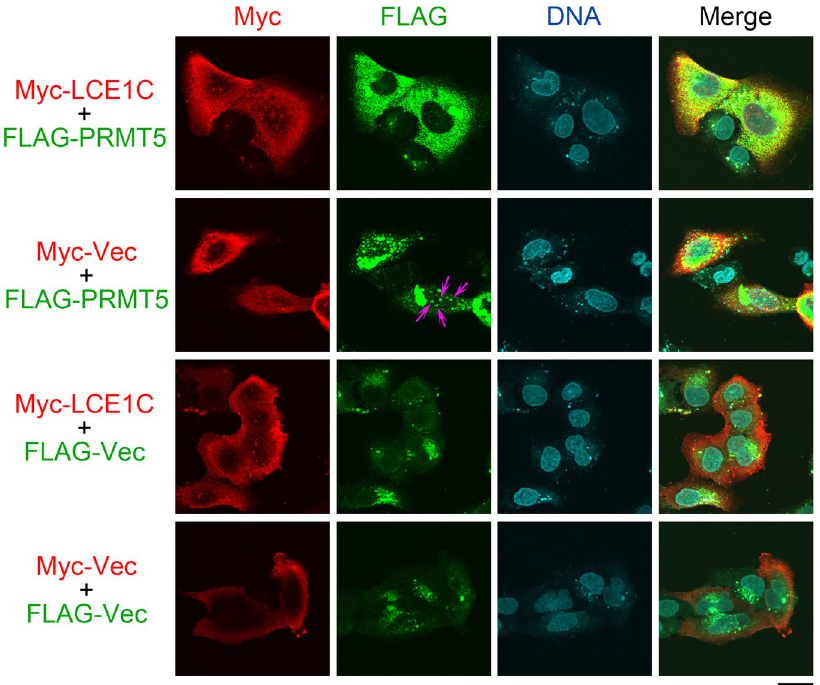
Figure 5. Subcellular localization of Myc-LCE1C and FLAG-PRMT5 in U2OS cells expressing these proteins. Pink arrows denote FLAG-PRMT5 signals showing nuclear dots. Scale bar, 30 µ